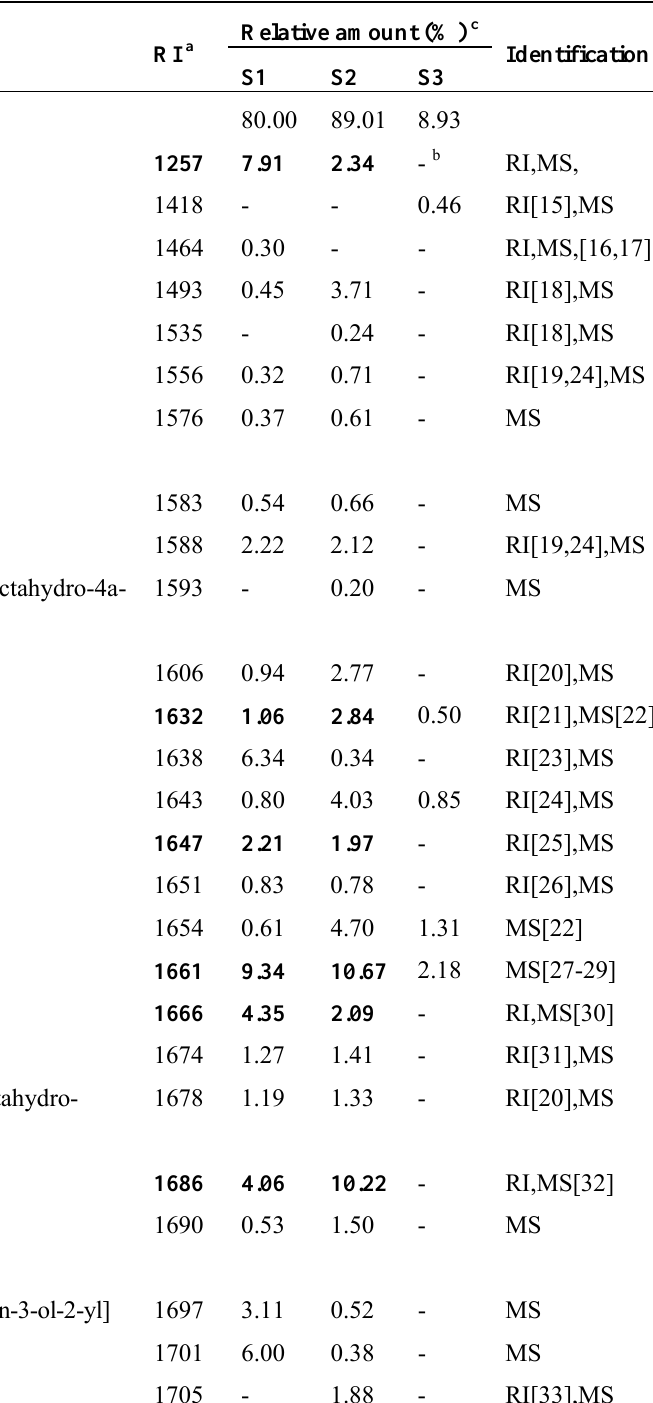
Table 1. Chemical compositions and relative amounts of the essential oils from S1, S2 and